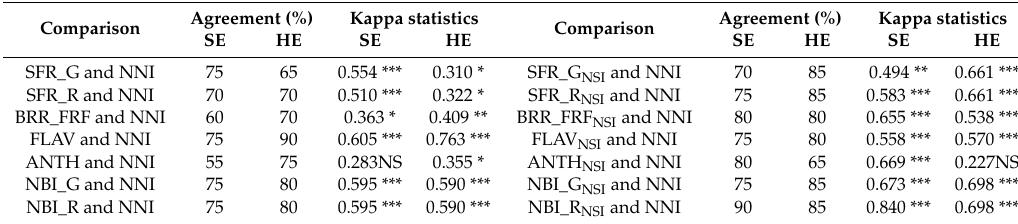
Table 6. Agreement and Kappa statistics for di ff erent indices (SFR_G, SFR_R, BRR_FRF, FLAV, ANTH, NBI_G, and NBI_R) and corresponding normalized indices (SFR_G NSI , SFR_R NSI , BRR_FRF NSI